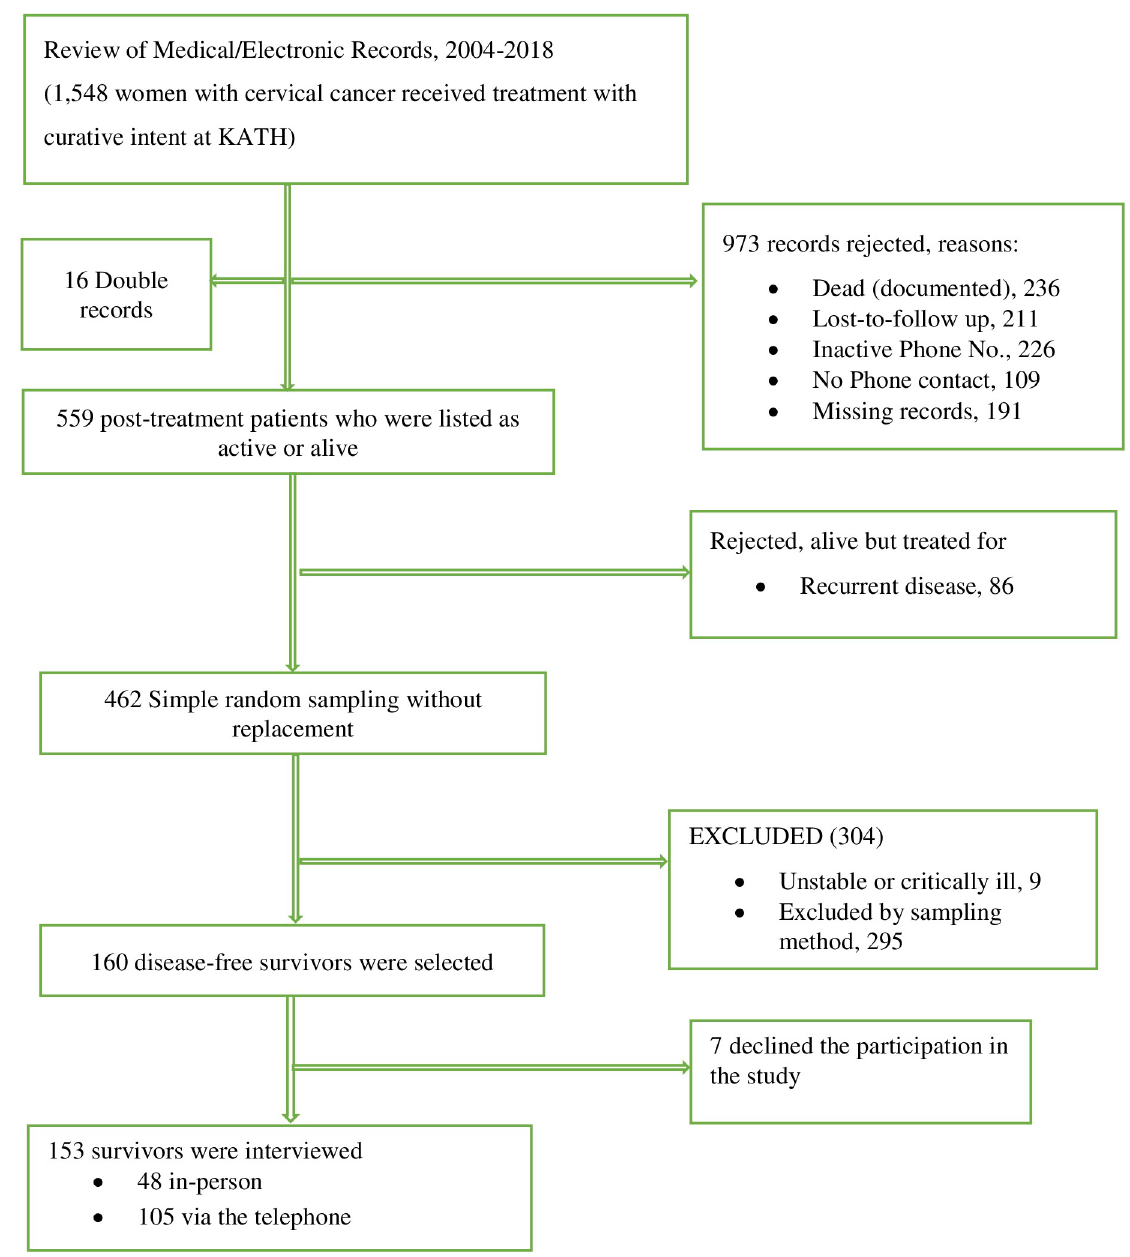
Fig 1. Flow chart of the sources of and selection of participants into the